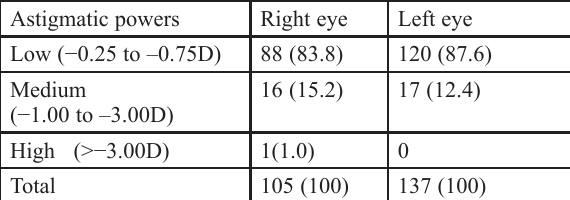
Table 3 Distribution of astigmatic powers according to their magni- tudes in the right and left eyes of the subjects. Most of the powers were of low magnitude (−0.25 to −0.75). Astigmatic powers Right eye Left eye